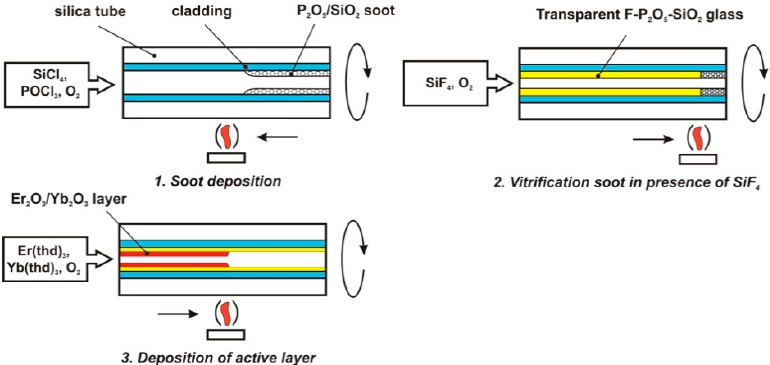
Figure 4. The schematically illustrated improved Er–Yb–FPS glass core fabrication process.